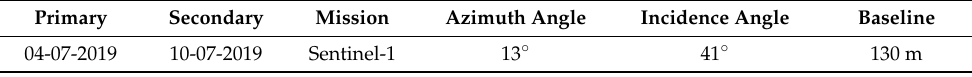
Table 1. Overview on the SAR data used in this